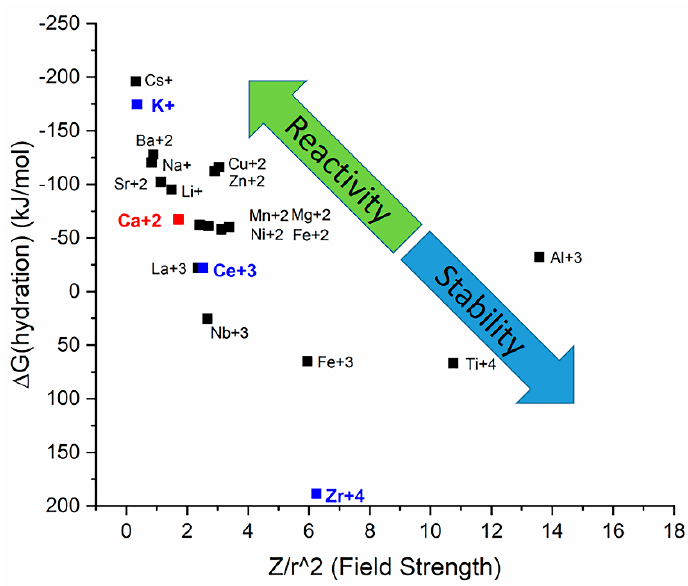
Figure 1. Gibbs free energy of hydration of glass additives relative to their ionic field strengths.